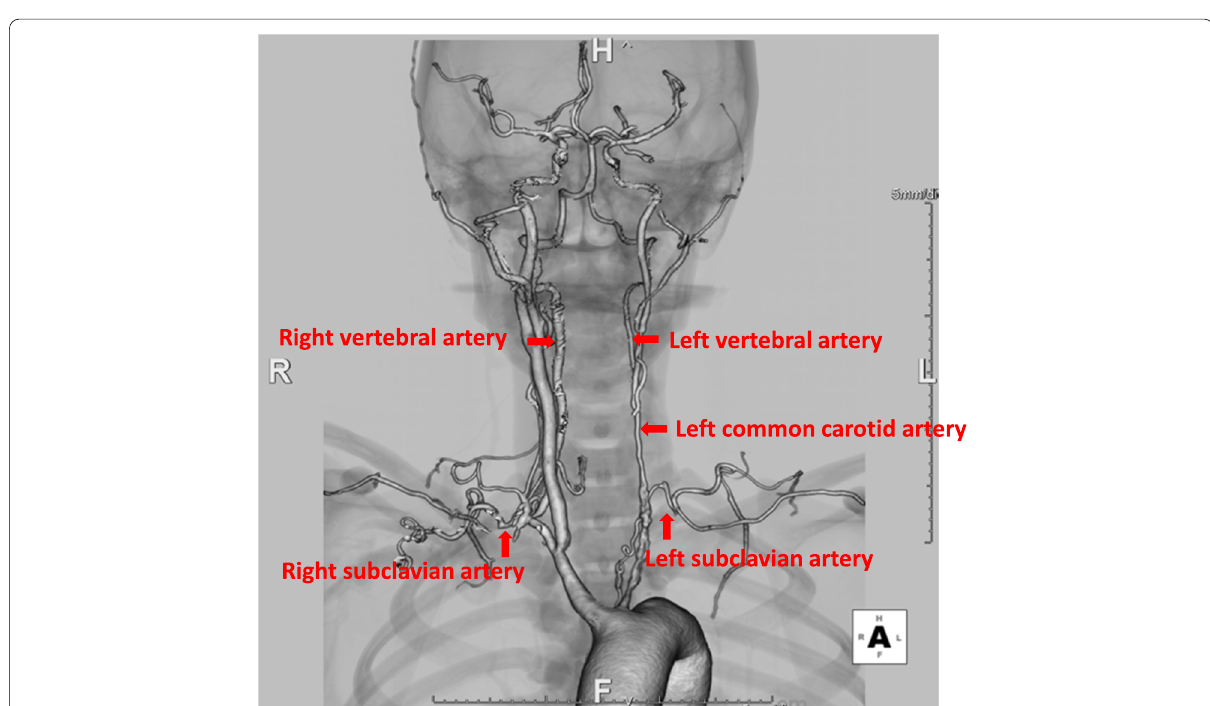
Fig. 1 Three-dimensional computed tomography. Stenosis of the left common carotid artery, bilateral vertebral arteries, and bilateral subclavian arteries is shown (directional